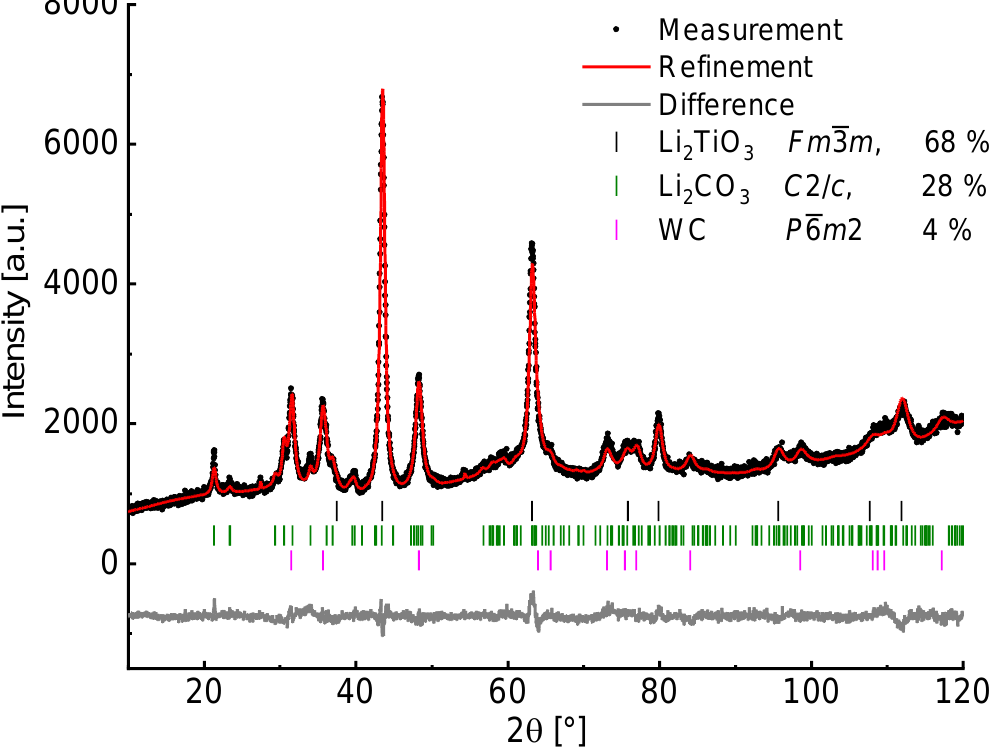
Figure 4. Rietveld plot of the milling product from LiOH and rutile (WC tools, 600 rpm, 6h). Li 2 TiO 3 in SG Fm − 3 m with a = 4.1588(2) Å, V = 71.93(1) Å 3 , number of reflections = 8 and R Bragg = 1.17%. Refinement parameters: number of independent parameters = 40, R wp = 3.44%, R exp = 2.60%, GOF = 1.32. For more detailed refinement parameters see Supplementary Materials Table S1.